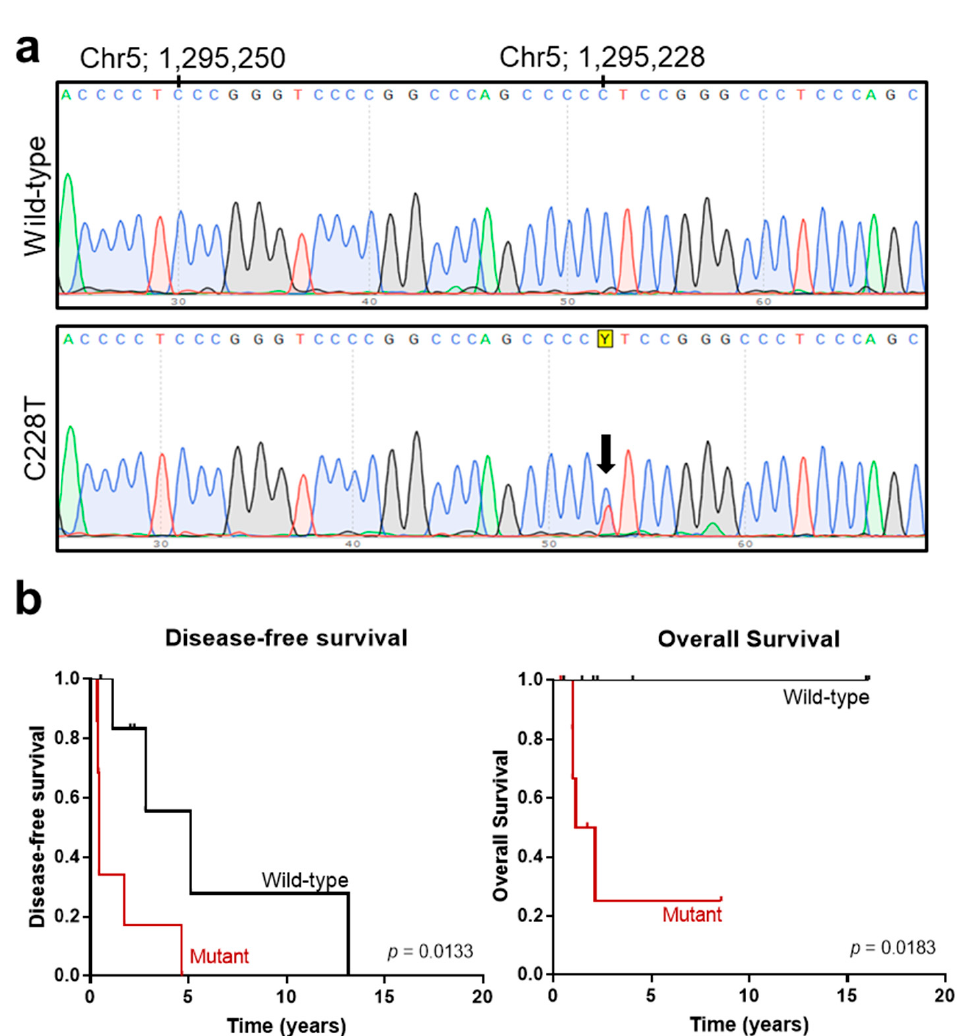
Figure 3. TERT gene promoter mutational analysis. ( a ) Representative chromatograms of wild-type ( top ) and C228T heterozygous mutation ( lower ) found in solitary fibrous tumors (SFTs). Yellow Y represents the standard abbreviations to represent C or T. ( b ) Kaplan–Meier survival curves of disease-free survival ( left ) and overall survival ( right ) stratified based on TERT promoter mutational status in SFTs. Table 4. Associations of TERT gene promoter mutations with clinicopathological parameters and gene fusion variants.